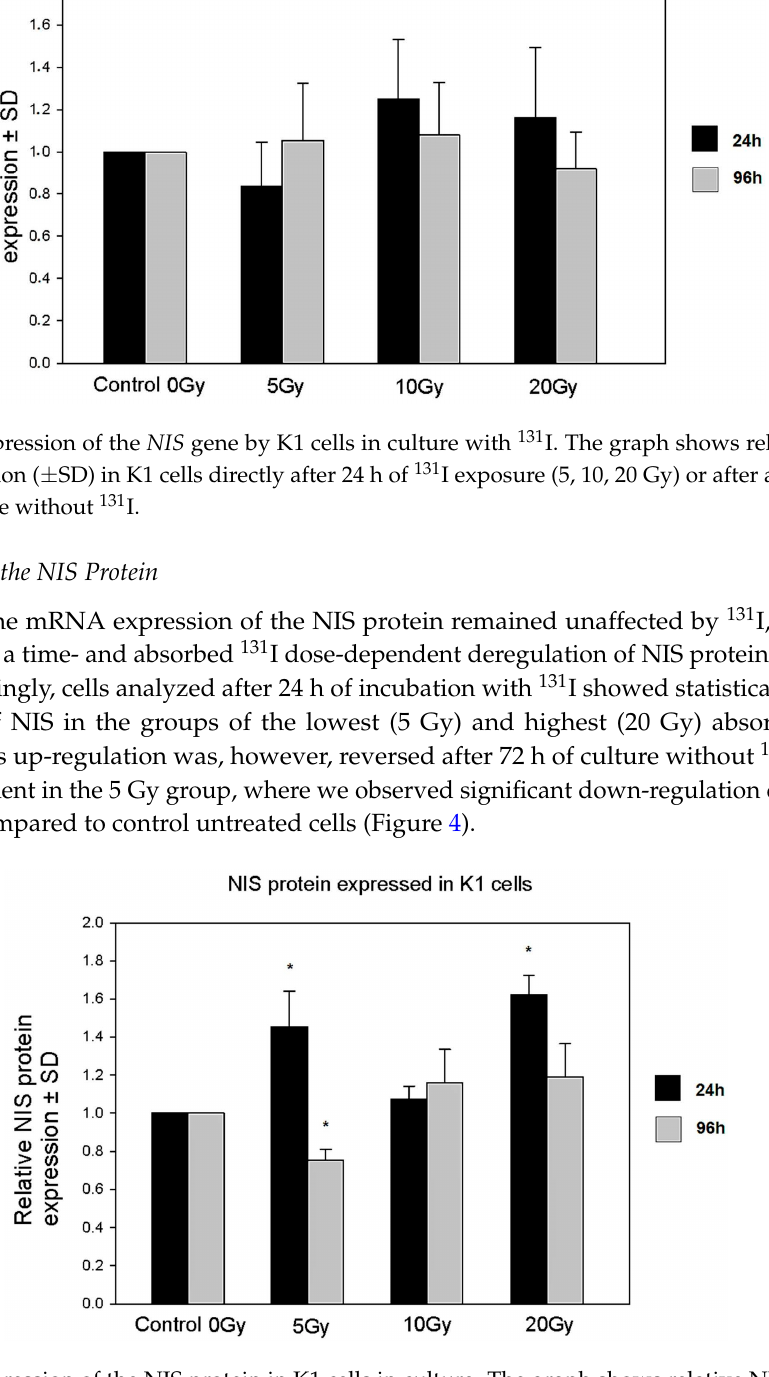
Figure 4. Expression of the NIS protein in K1 cells in culture. The graph shows relative NIS protein expression ( ± SD) obtained from cultured K1 cells directly after 24 h of 131 I exposure (5, 10, 20 Gy) or after additional 72 h of culture without 131 I (* p < 0.05).